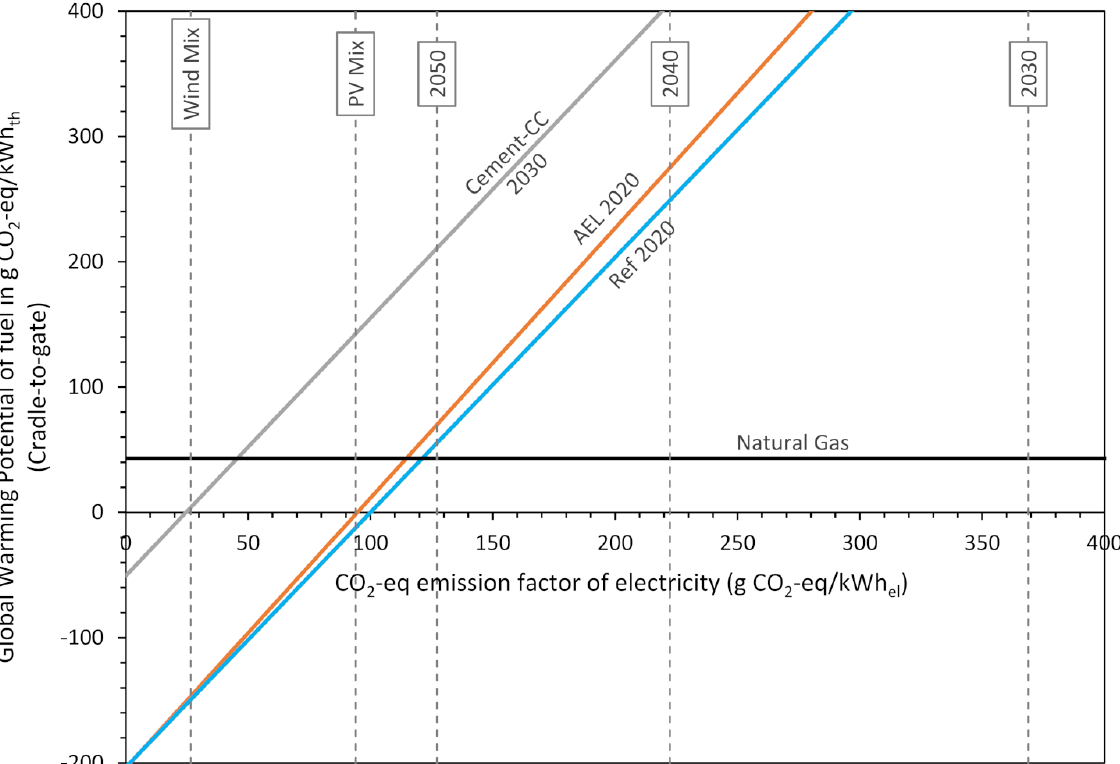
Figure 12. Global warming potential of PtSNG scenarios and conventional natural production as a function of CO 2 emission factor of electricity supply. The vertical lines represent the CO 2 emission factors of electricity supply from the forecasted German electricity mixes as described in the Supplementary Materials Section